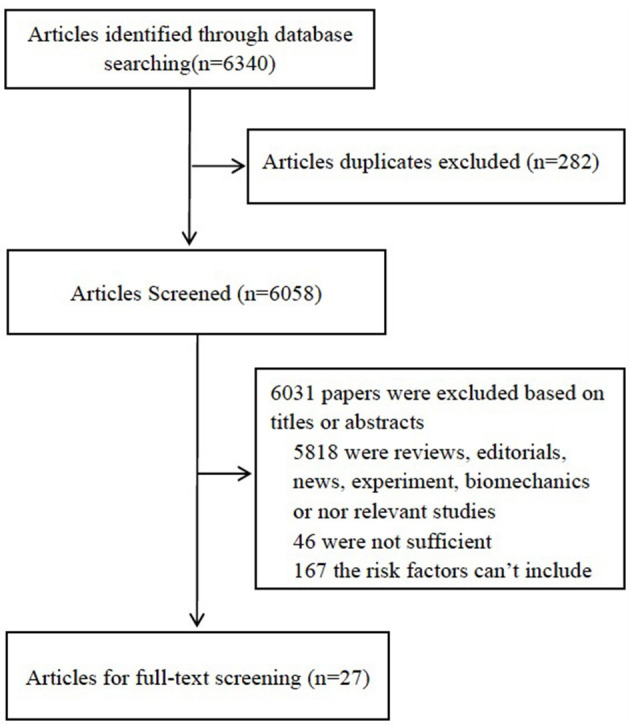
Flow diagram of identification of relevant observational studies of ambient air pollution in relation to the risk of MI.